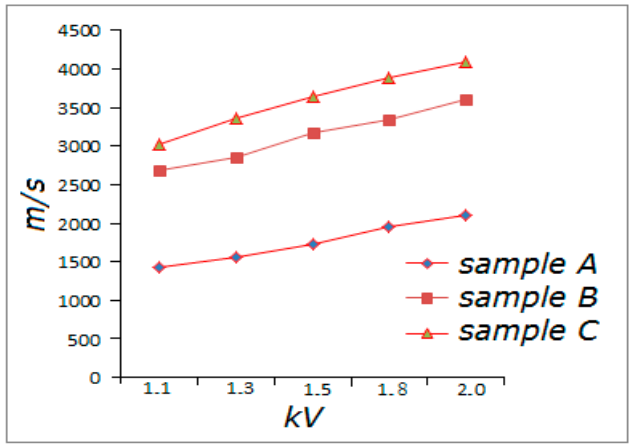
Figure 9. The flyer speed of three samples under different driving voltages.